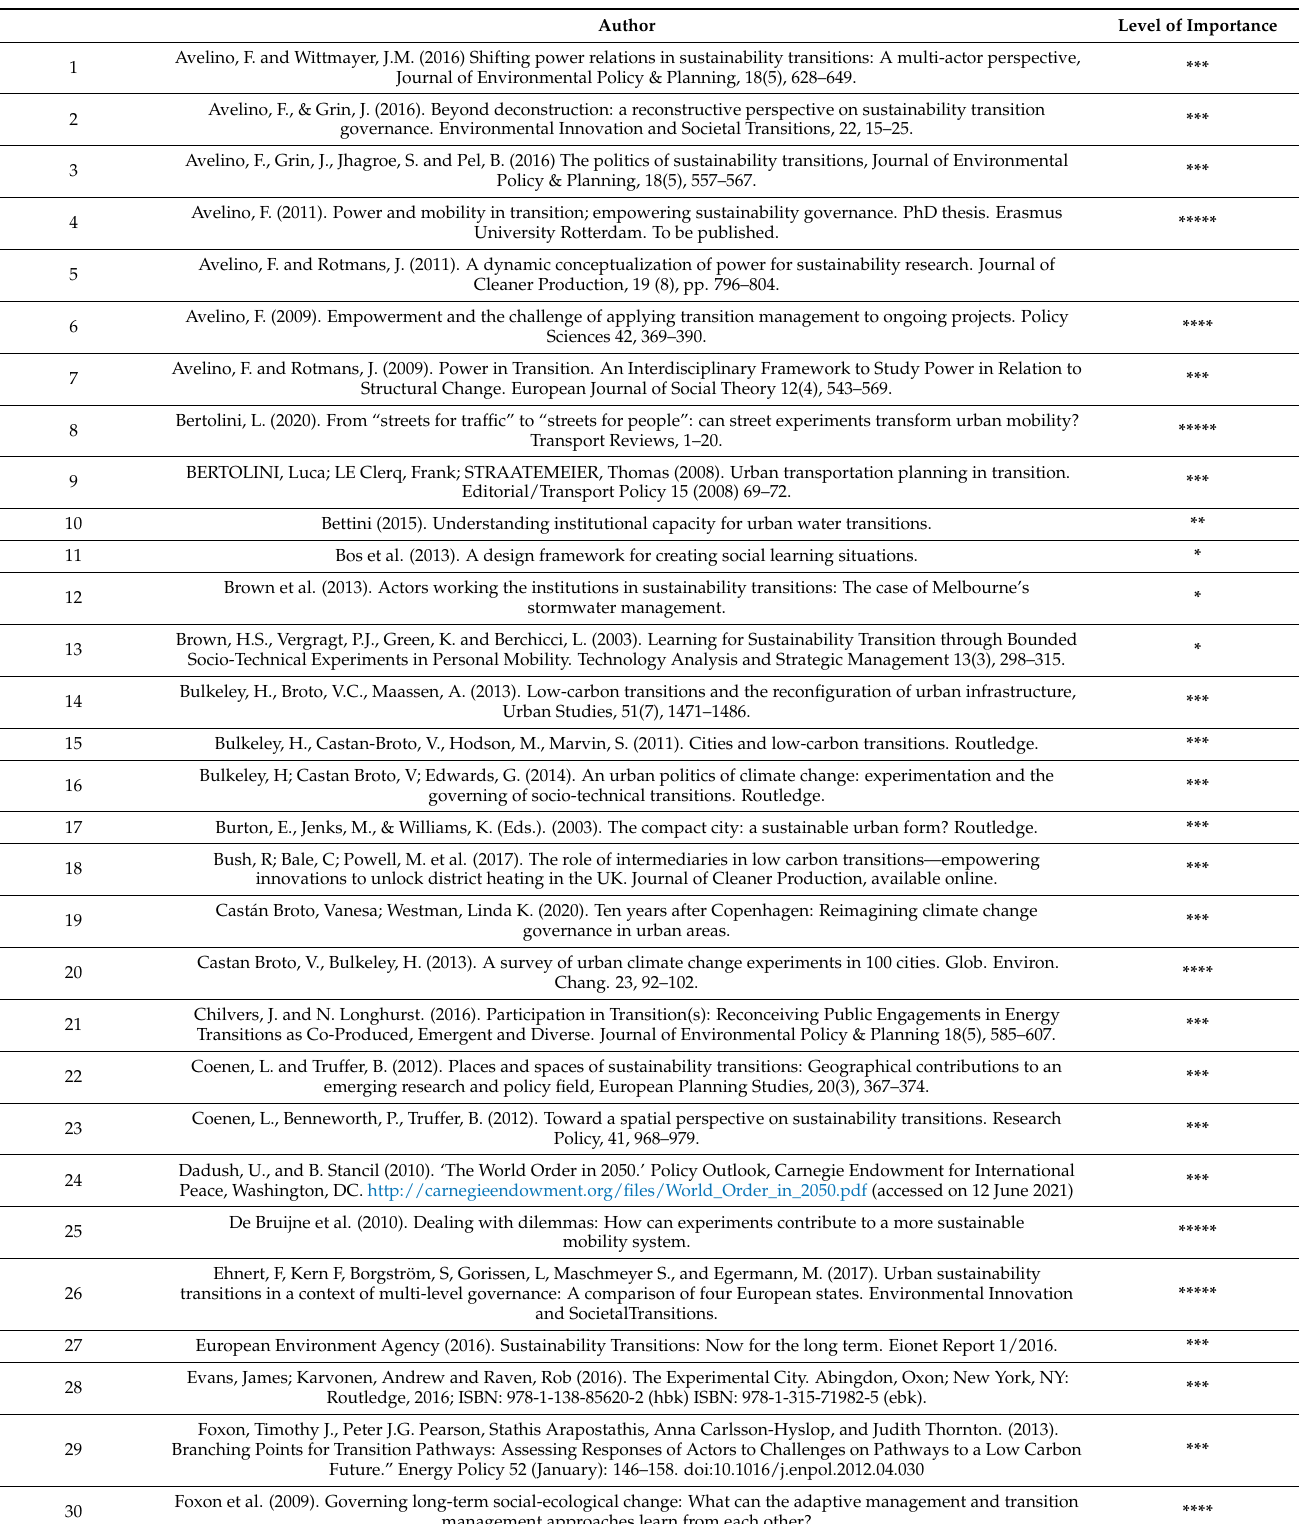
Table A1. Level of importance of the 120 publications of TE